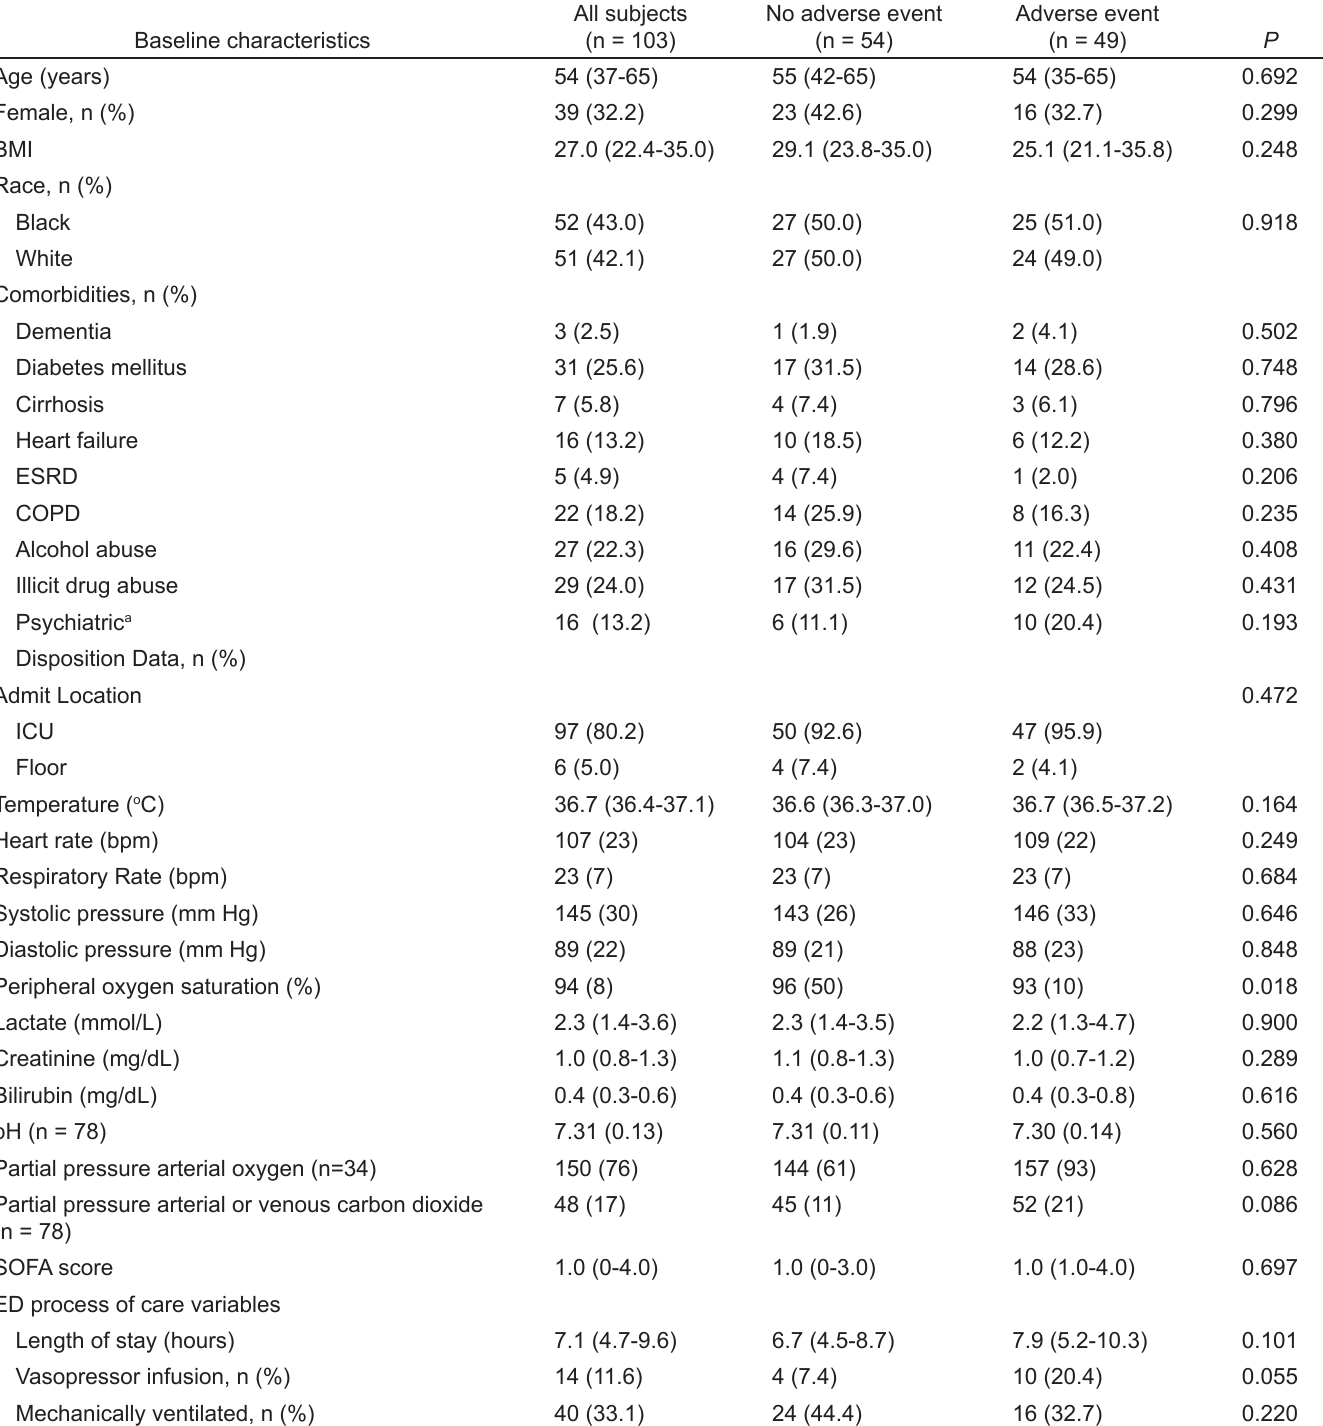
Table 1. Characteristics of included study